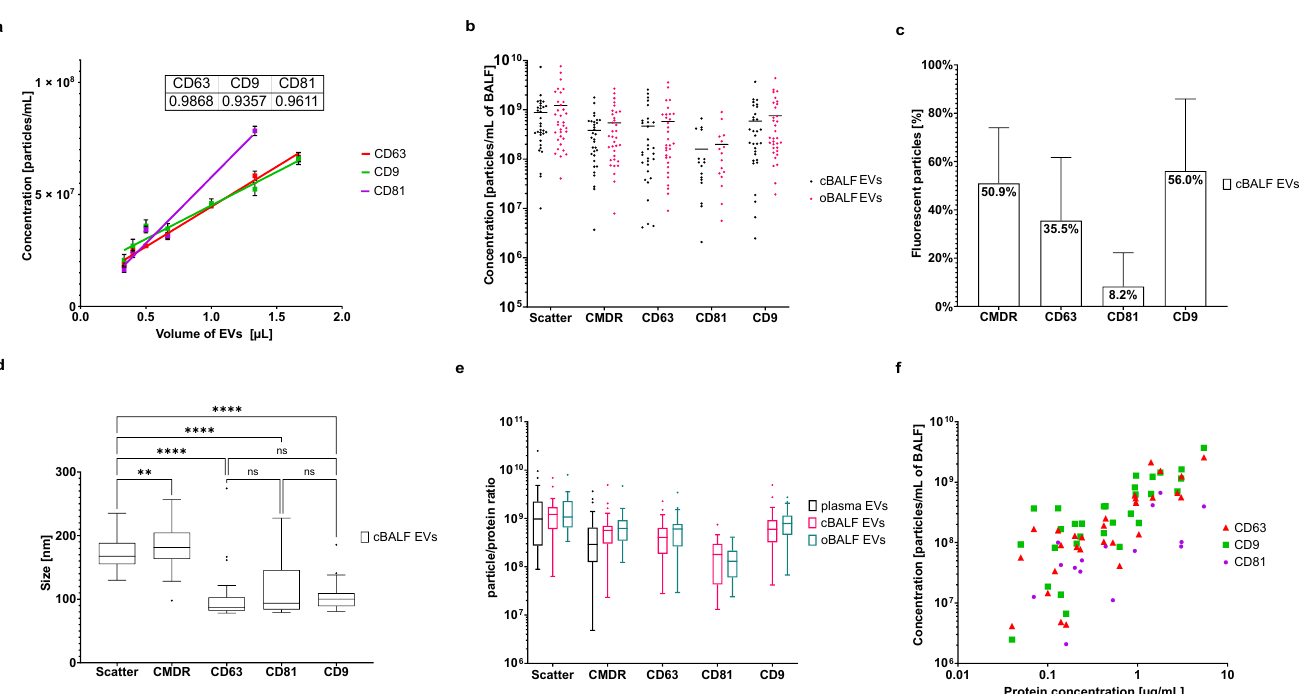
Figure 6. FL-NTA characterization of BALF EVs. ( a ) Concentration of BALF-derived particles measured in fluorescent mode (488 nm) after labeling with tetraspanin markers depending on the EV sample volume taken for the measurement. A line from simple linear regression was plotted and R 2 was placed in the table for each tetraspanin marker. ( b ) Concentration of particles calculated per one mL BALF for cBALF-EVs and oBALF-EVs for all patients in FL-NTA. ( c ) The percent of fluorescent particles in comparison to all particles visible in scatter mode for cBALF EVs for all patients. ( d ) Measured mode sizes of particles in the scatter and fluorescent mode (488, 640 nm) for cBALF EVs for all patients. ( e ) Particle/protein ratio of plasma and BALF-EVs in the scatter and fluorescent mode. ( f ) Correlation between the concentration of particles and protein concentration of tetraspanin-positive cBALF-EVs. Graph ( c ) presents the mean and SD for all patients. Graphs ( d , e ) present the Tukey plot for all patients. **** refers to p value ≤ 0.0001, ** refers to p value ≤ 0.0021, ns refers to p value > 0.05 from t -test-paired comparison ( d ) and Wilcoxon test-paired comparison ( e